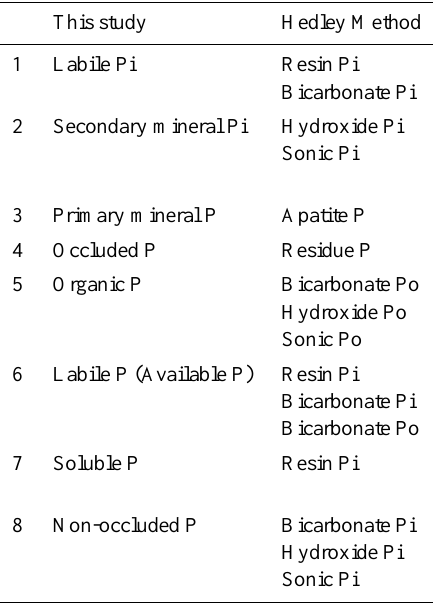
Table 2. Terminology of phosphorus forms used in this study and their correspondence to the defined P fractions using Hedley method.